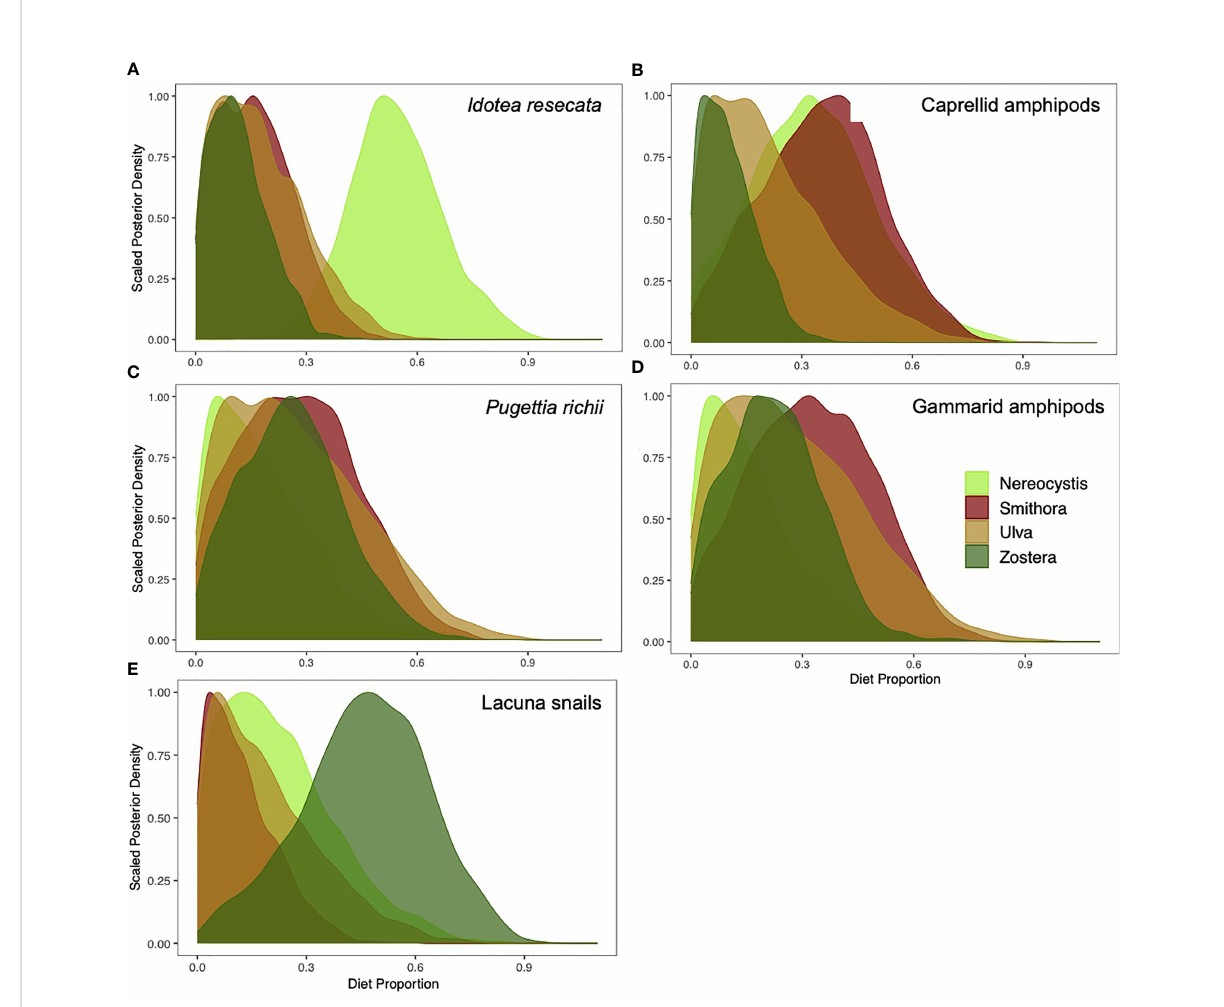
FIGURE 4 Proportion of N. luetkeana , S. naiadum, U. lactuca , and Z. marina that contributed to mesograzers diets: (A) I . resecata , (B) caprellid amphipods (C) P. richii crabs, (D) gammarid amphipods, and (E) Lacuna